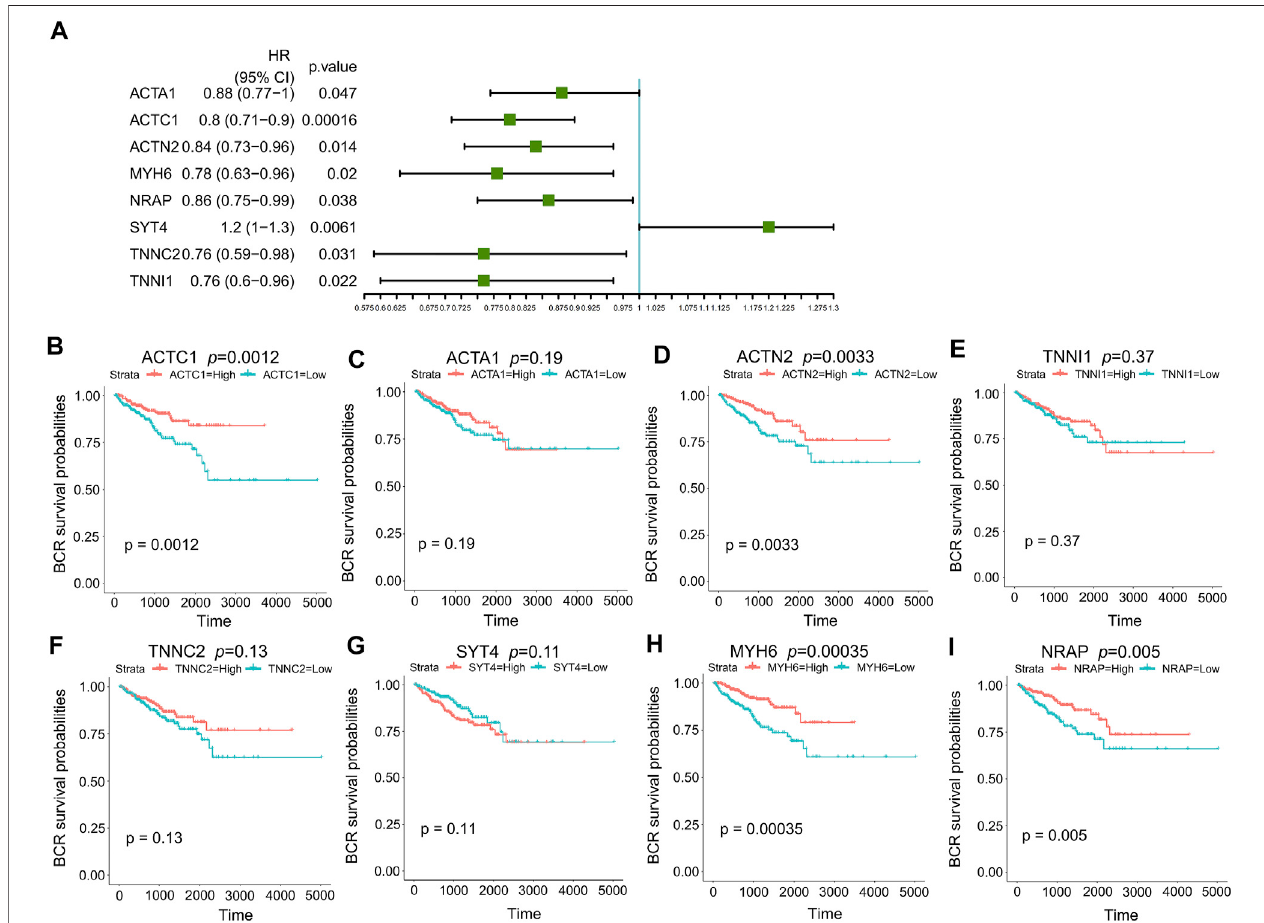
FIGURE6| Prognosisanalysisofeighthubgenes. (A) p valueandHRofeighthubgenesinunivariateCoxregressionanalysis; (B) Kaplan – Meiercurvesof ACTC1 ; (C) Kaplan – Meier curves of ACTA1 ; (D) Kaplan – Meier curves of ACTN2 ; (E) Kaplan – Meier curves of TNNI1 ; (F) Kaplan – Meier curves of TNNC2 ; (G) Kaplan – Meier curves of SYT4 ; (H) Kaplan – Meier curves of MYH6 ; (I) Kaplan – Meier curves of NRAP . HR: hazard ratio.